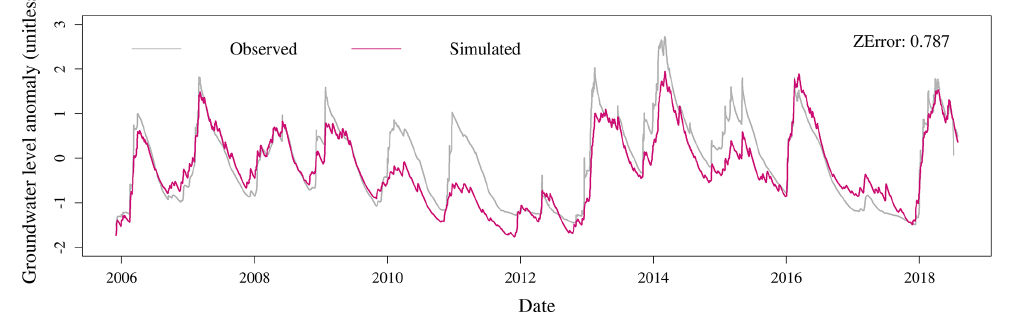
Figure 13. Observed and simulated groundwater levels in the Seudre catchment, where the simulated groundwater level was obtained with the new calibration frameworks: second